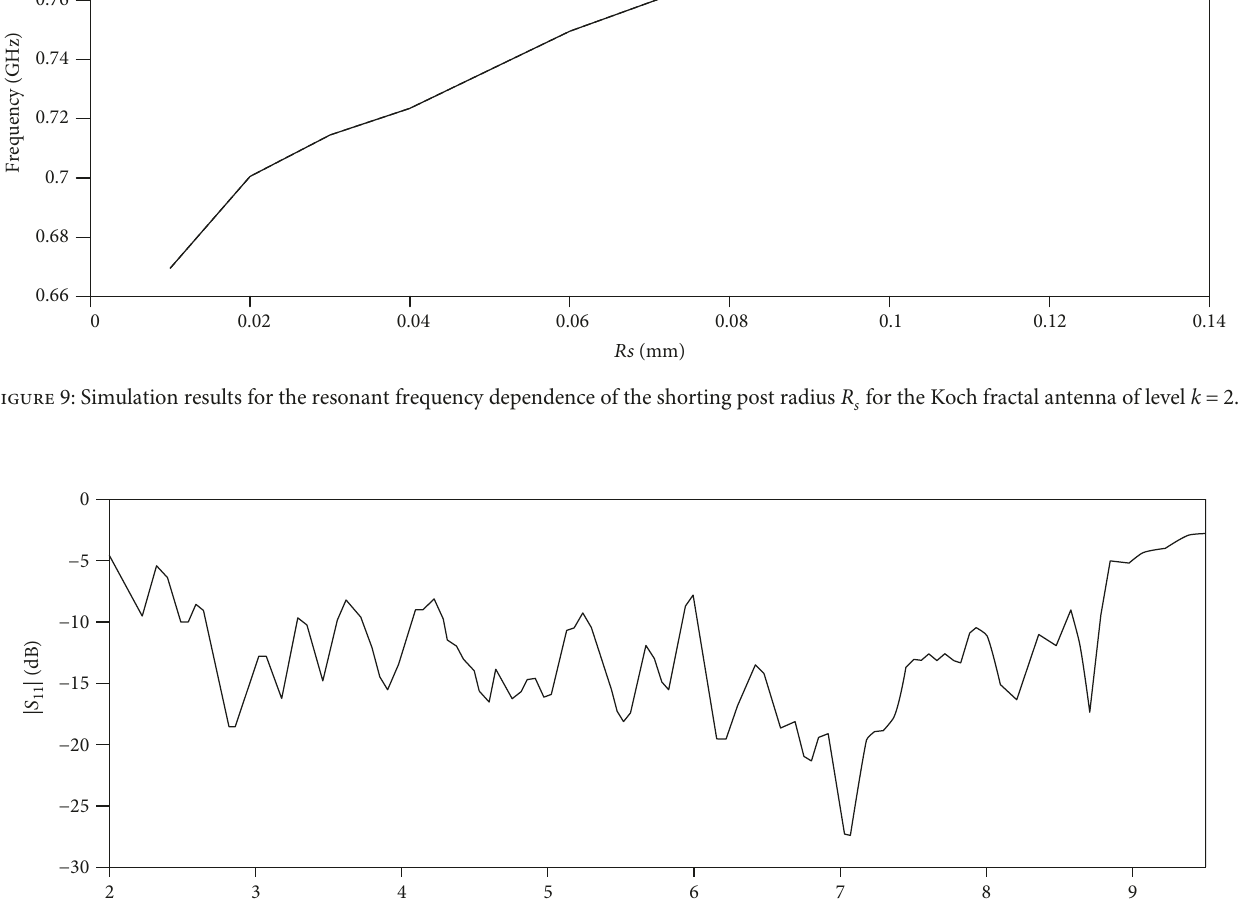
, for the Koch fractal antenna of level k = 2 0